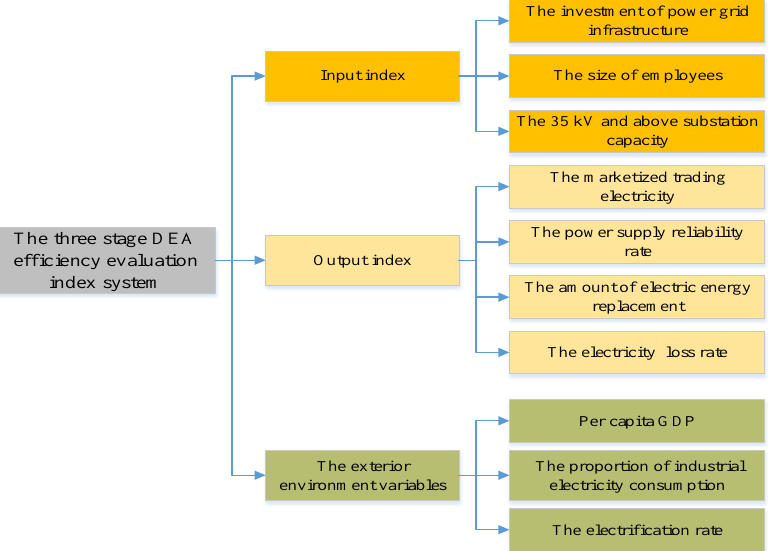
Figure 2. The index system for investment e ffi ciency of PGEs. DEA: data envelopment analysis. Figure 2. the index system for investment efficiency of PGEs. DEA: data envelopment analysis.